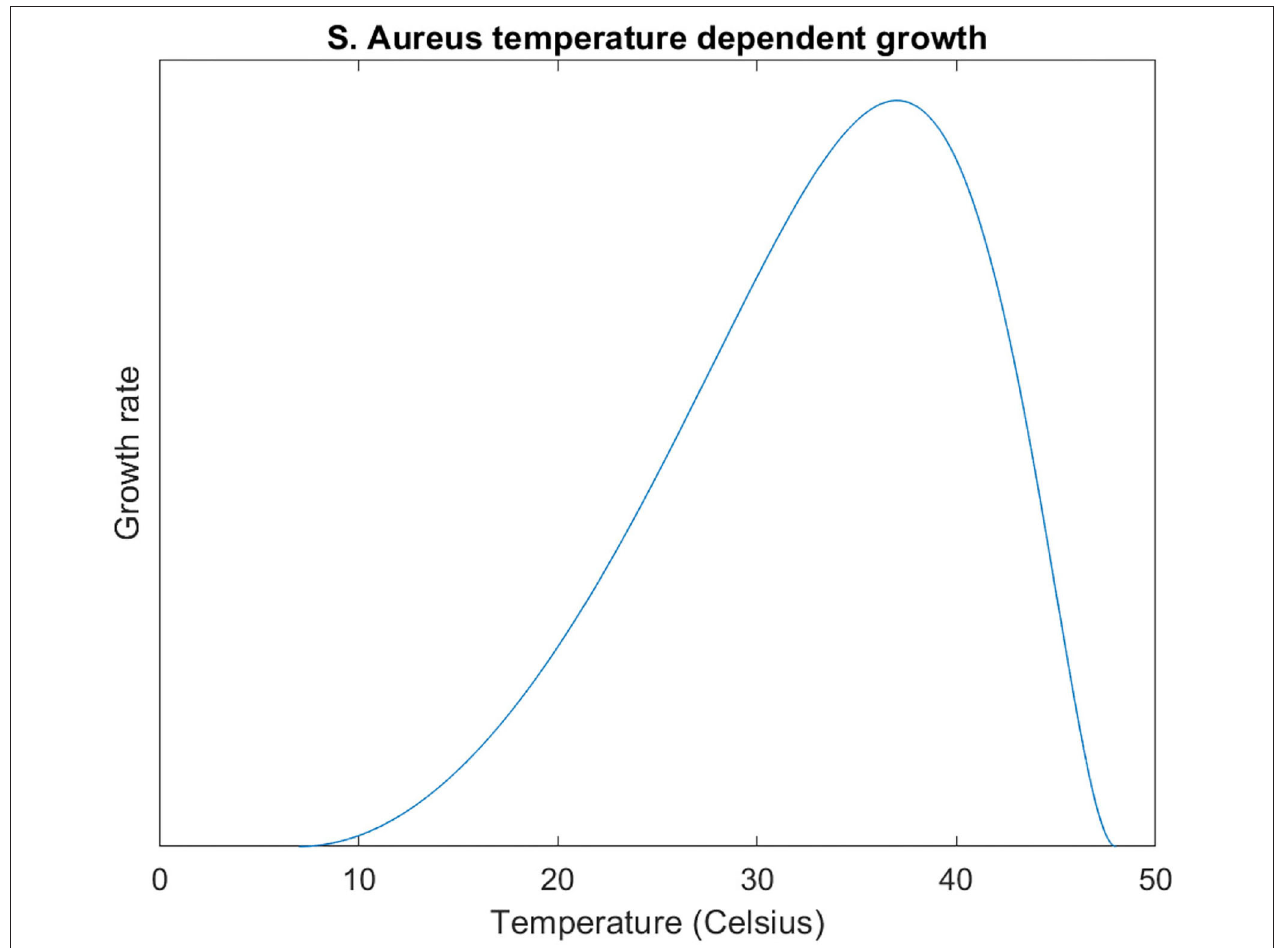
T min ) e 0.16 · ( T − T max ) ). ( T (1 = − · −